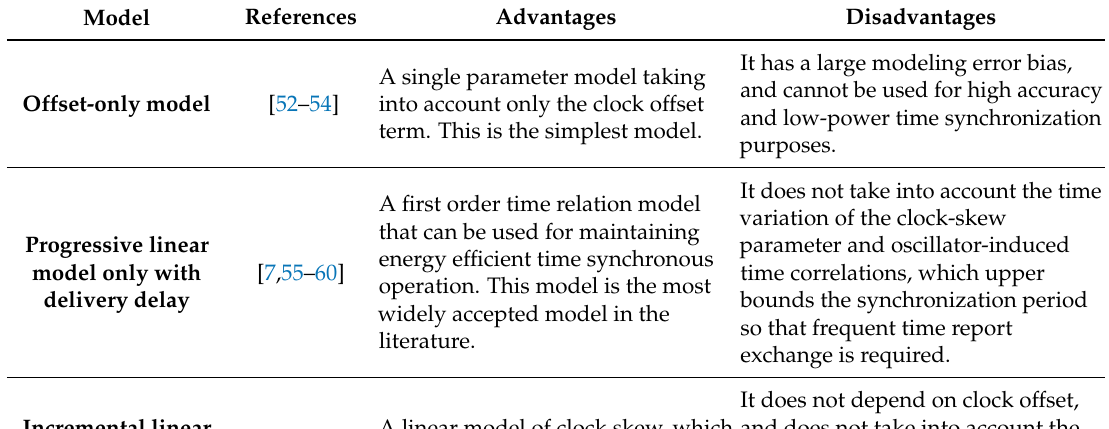
Table 4. Summary of clock relation